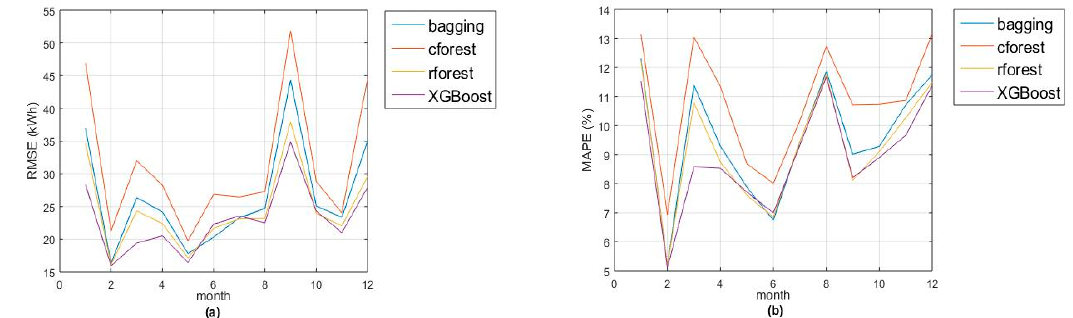
Figure 1. Goodness-of-fit measures for each month in 2016 and each ensemble method: ( a ) using root mean square error (RMSE) (kWh); and, ( b ) using mean absolute percentage error (MAPE) (%).